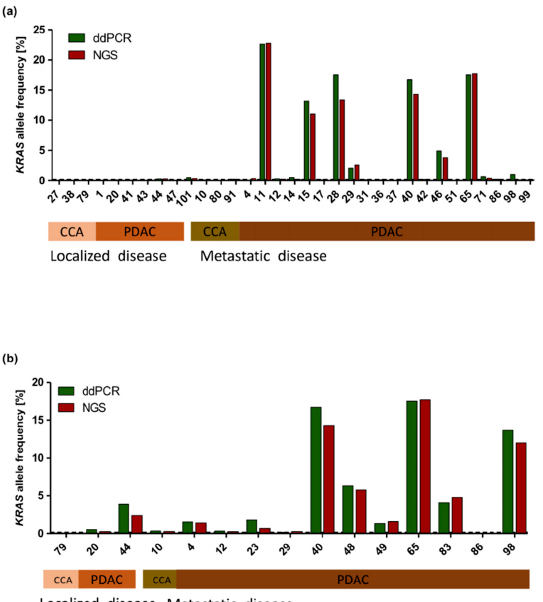
Figure 4. Comparison of KRAS allele frequency measured by NGS vs. ddPCR. KRAS allele frequency displayed in tumor samples measured by ddPCR (green) and NGS (red) in plasma ( a ) and bile samples ( b ). Some patients had to be excluded from analysis because of insufficient quantity of DNA or because of KRAS mutations in codon